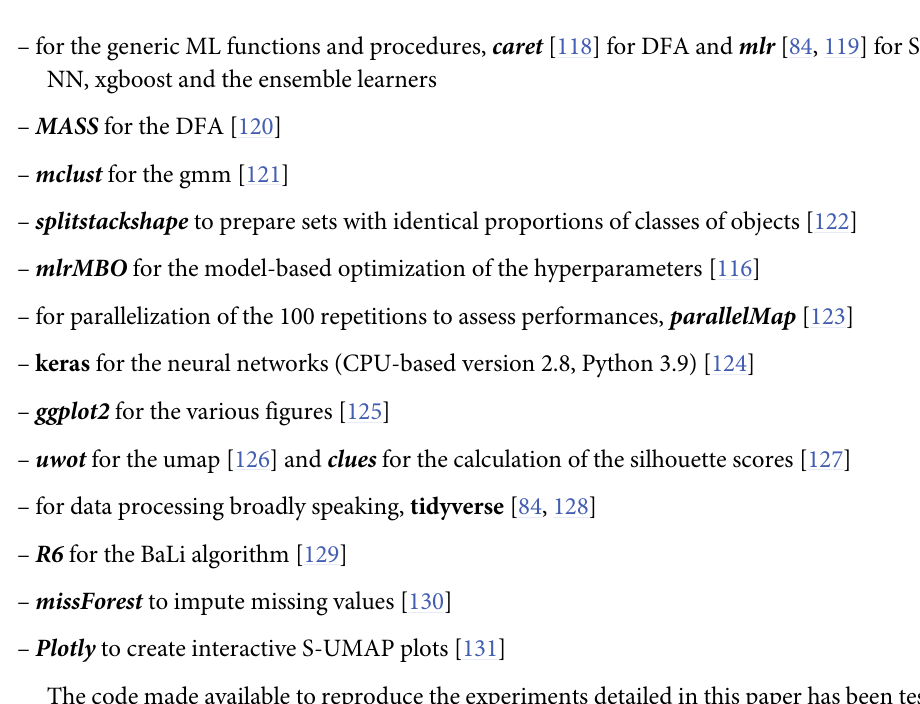
S1 Fig. Examples of spectrograms of the five call types. S1 Table. Description of the acoustic features and feature